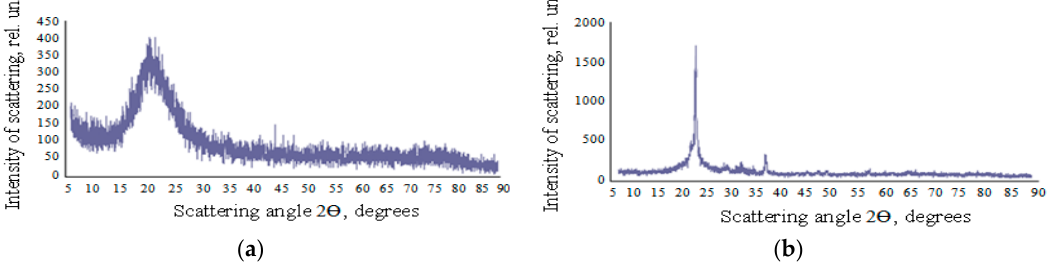
Figure 13. The XRD data of the nanopowder: ( a ) before calcination; ( b ) after calcination; Ө is the angle between the plane of the sample and the direction of radiation incidence. ARL X’TRA device (CuKa radiation, wavelength: 1.54 Å).